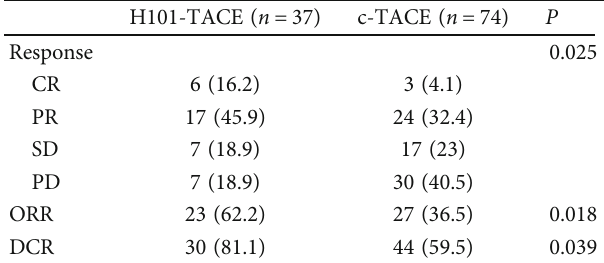
Table 4: Tumor responses in two